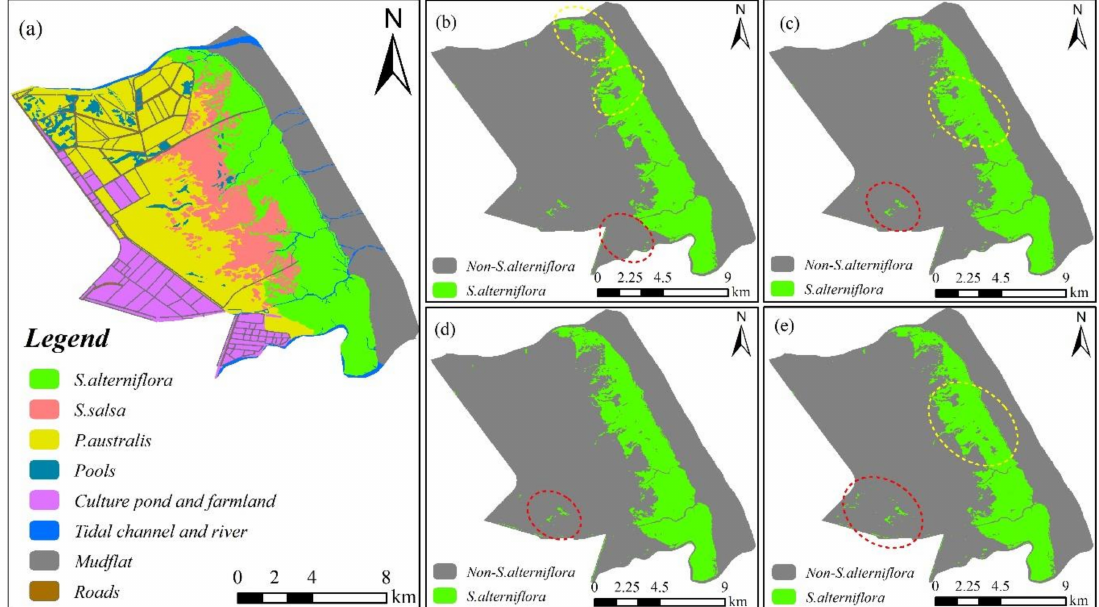
Figure 4. Classification maps for the first study area. ( a ) Land-cover classification map generated with a visual interpretation method based on the GF-1 WFV image and Google Earth (GE) image. ( b ) Classification map using the EOCC algorithm in November; ( c ) Classification map using the EOCC algorithm in NDVI-TSA with the top three variables. ( d ) Classification map using the EOCC algorithm in NDVI-TSA with the optimal six variables. ( e ) Classification map using the EOCC algorithm in NDVI-TSA with 12 variables. The red circle shows the false positive pixels (pixels are not S. alterniflora , but are classified as positives), and the yellow circle shows the false negative pixels (pixels are S. alterniflora , but are classified as